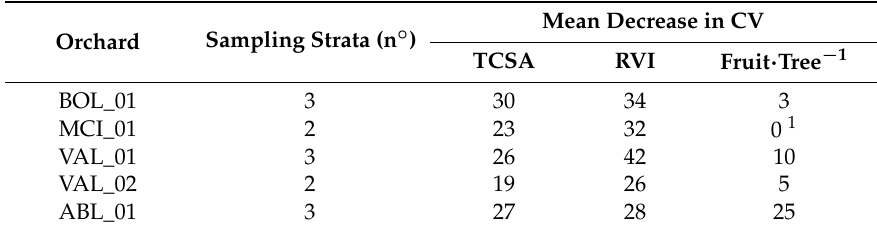
Table 3. Number of sampling strata identified in the orchards, mean decrease in variability (CV, %) of tree characteristics within each stratum compared to the variability detected in the whole orchard. Mean Decrease in CV Orchard Sampling Strata (n ◦ ) TCSA RVI Fruit · Tree − 1 BOL_01 3 30 34 3 MCI_01 2 23 32 0 1 VAL_01 3 26 42 10 VAL_02 2 19 26 5 ABL_01 3 27 28 25